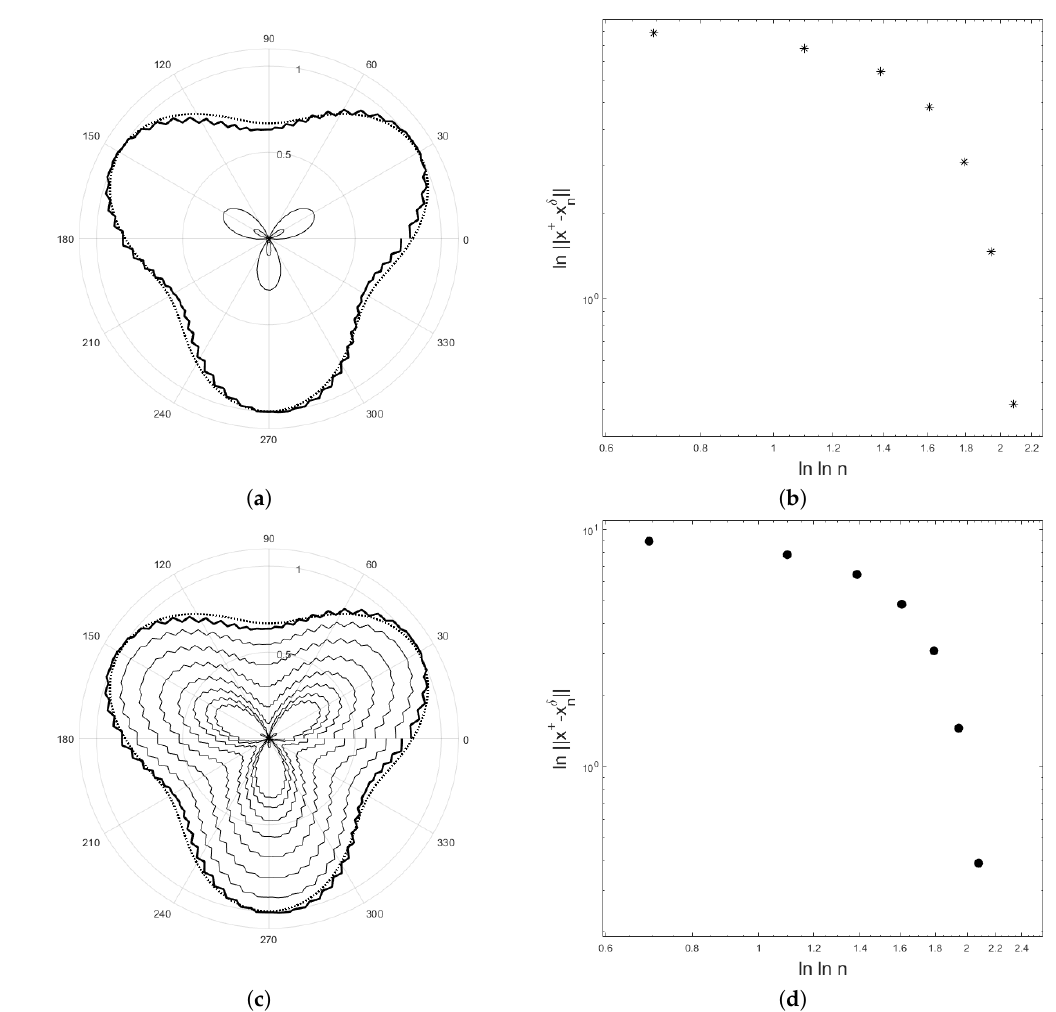
Figure 4. The polar plot shows the exact solution (dot line) and the computed solution (solid line) for ( a ) i max = 3 and ( c ) i max = 6 with δ = 0.01. In ( a ) the thin curve is an initial value. In ( c ) the thin curves are the curve of x δ n for n = 1, . . . ,8. The error iteration step using a double logarithm scale for ( b ) i max = 3 and ( d ) i max = 6 are shown. The initial value is x 0 = 0.1 + 1 sin ( 3 s ) . The parameter α n in Equation (71) is 1 5